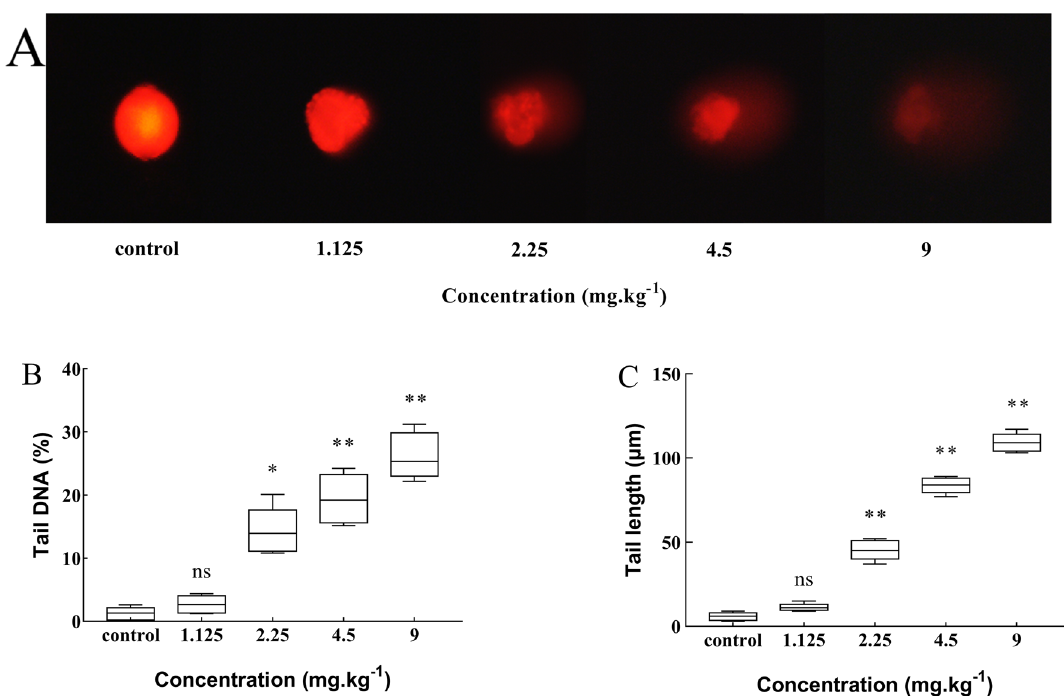
Figure 5. DNA damage in the midgut cells of Drosophila third instar larvae under Cd stress. ( A ) Comet images of midgut cells in third instar larvae indicated the DNA “smearing” phenomenon of Drosophila larvae was serious with the increase of Cd concentration. ( B ) Tail DNA% of comet at increasing Cd concentration. ( C ) Tail length of comet at increasing Cd concentration. The increase of tail DNA% and tail length of comet indicating clear DNA damage in treatment groups (2.25 mg/kg, 4.5 mg/kg, 9 mg/kg). (Mean ± SD, n = 3, 50 larvae per sample, * P < 0.05, ** P < 0.01, ns = not